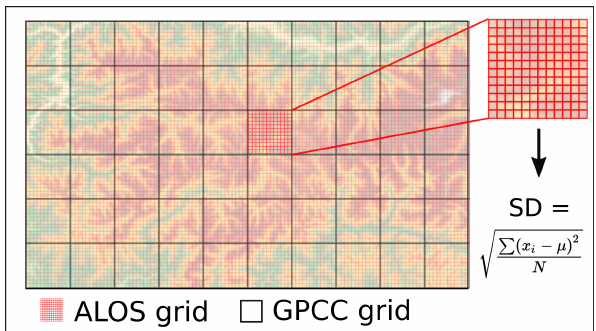
Figure 2. Schematic overview of the method applied to derive terrain complexity. Black lines represent the grid of the lowest resolved precipitation product (GPCC), red lines represent the grid of the ALOS digital elevation model (DEM). The topography in the background is an example topography. In the equation to calculate the DEM standard deviation (SD) in each GPCC grid cell, x i stands for the values within the ALOS DEM cell, µ for the overall mean and N for the number of ALOS DEM grid cells within each GPCC grid